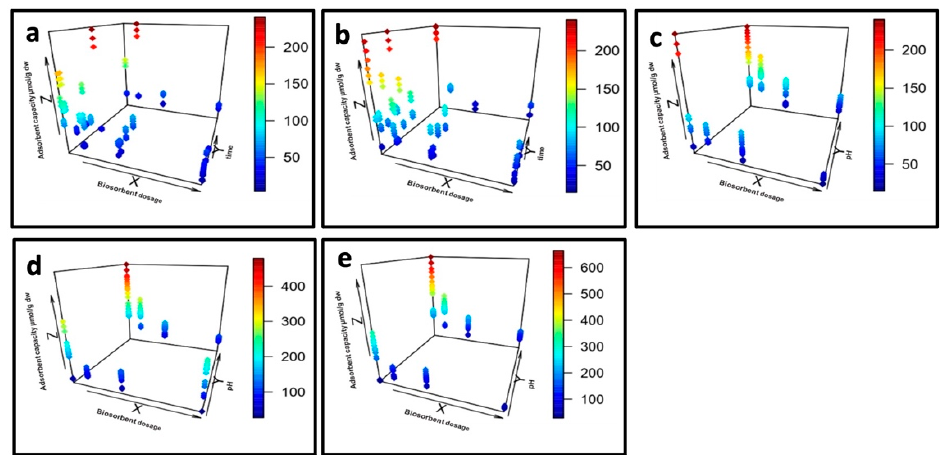
Figure 3. A 3D scatter plot of adsorption capacity. a ) Y. Effect of biosorbent dosage and time; b ) Ce. Effect of biosorbent dosage and time; c ) Ce. Effect of biosorbent dosage and pH; d ) Eu. Effect of biosorbent dosage and pH; e ) Tb. Effect of biosorbent dosage and pH. Table 2. Analysis of variance (two way-ANOVA), regression coefficient estimates and test of